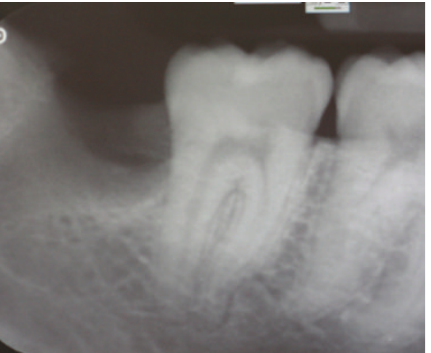
Figure 4: Preoperative periapical X-ray of the lower right second